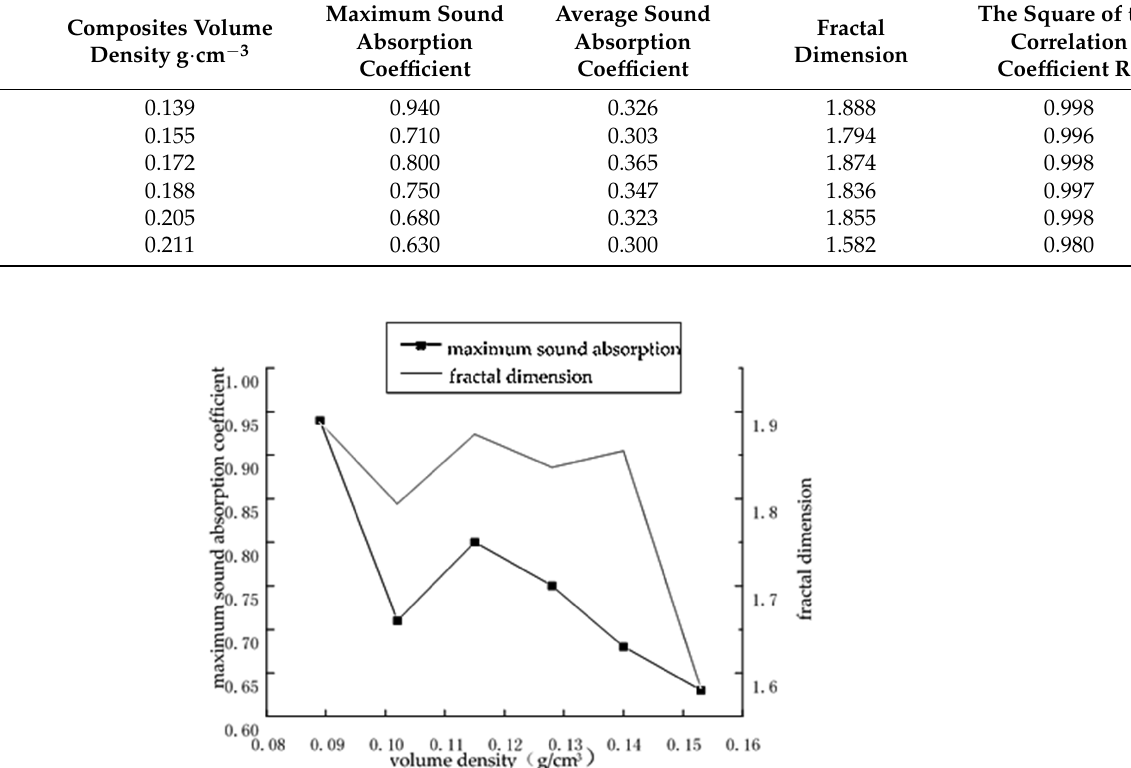
Table 2. Relevant parameters of samples under different kapok fibre mass fractions . Sample Number